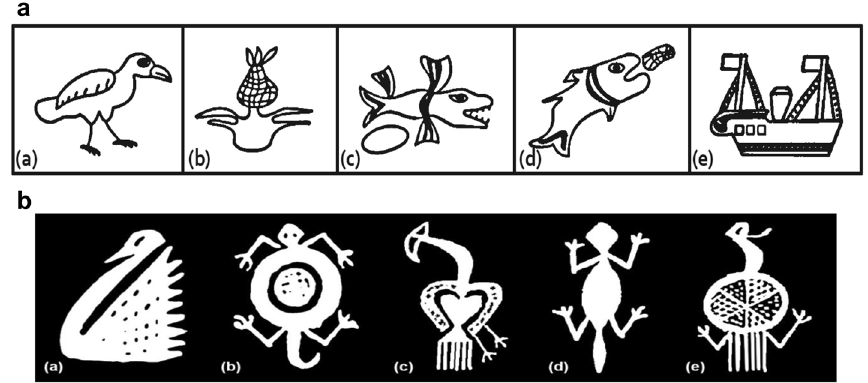
Fig. 2 a African figurative motifs found in Fon Applique cloth in Benin. (a) Kpengla (the sparrow), (b) Agonglo (the pineapple), (c) Behanzin (the shark and the egg), (d) Houegbadja (the fish and the wicker fish trap) and (e) Agadja (the ship). Adapted from Akrofi et al. (2016), (CC BY-NC-ND 4.0). b African figurative motifs used for Adire cloth in Nigeria. (a) Eye (bird), (b) Alangba berekete (fat lizard), (c) Adan (bat), (d) Alangba (lizard) and (e) Oobe (smaller specie of bat). (Adapted from Areo and Kalilu (2013), (CC BY